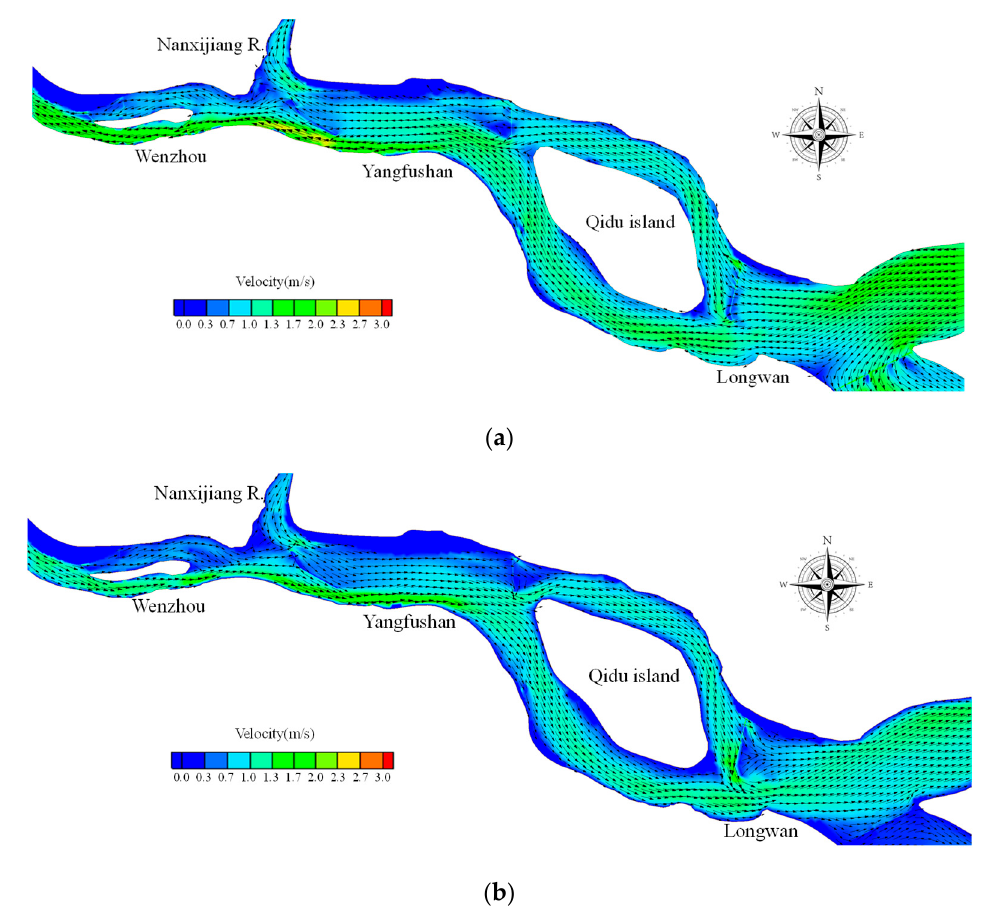
Figure 4. The flow field distribution during spring tide in October 2017: ( a ) Tidal current field at flow strength ; ( b ) Tidal current field at ebb strength.